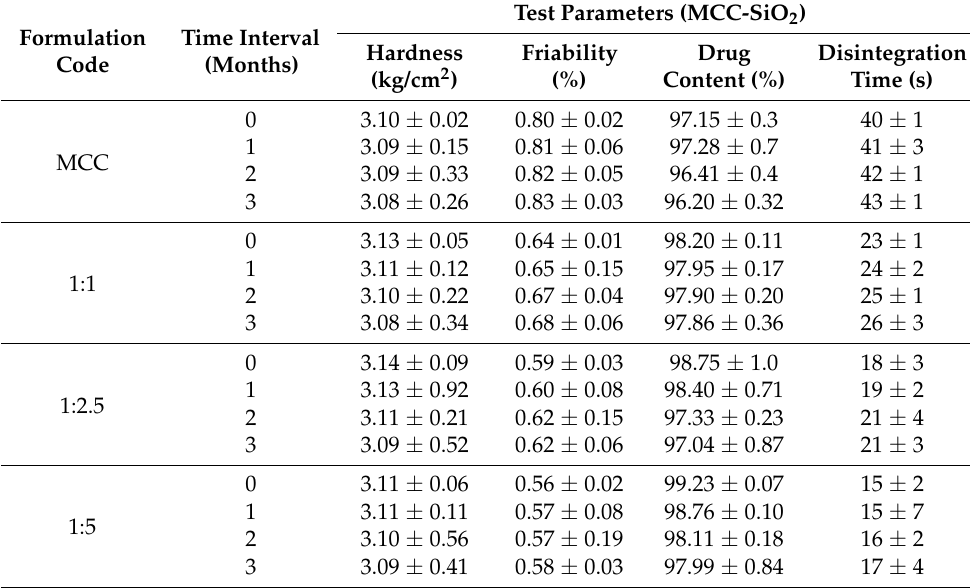
Table 9. Stability study for the prepared MCC-SiO 2 FDTs.